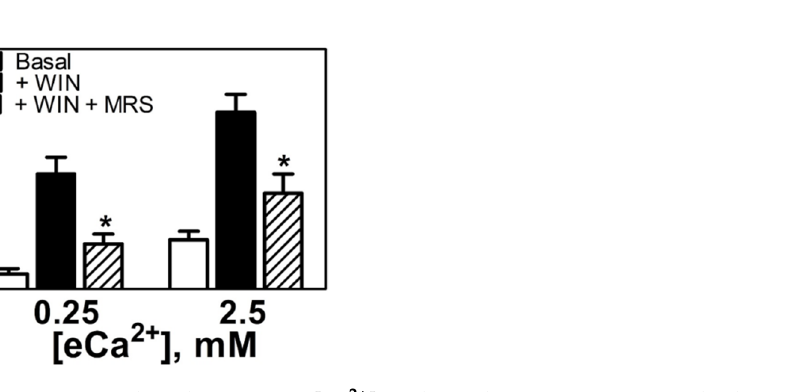
Figure 4. WIN55212-2-mediated increase in [Ca 2+ ] i is dependent on store operated calcium entry. Increases in [Ca 2+ ] i in low (0.25 mM) and high (2.5 mM) eCa 2+ in basal conditions (Basal, n = 6), in the presence of WIN55212-2 (5 μ M, n = 7) (+WIN), and in the presence of WIN55212-2 plus MRS1845 (+WIN + MRS, n = 4 or n = 7) (10 μ M). * p < 0.05 vs. +WIN.